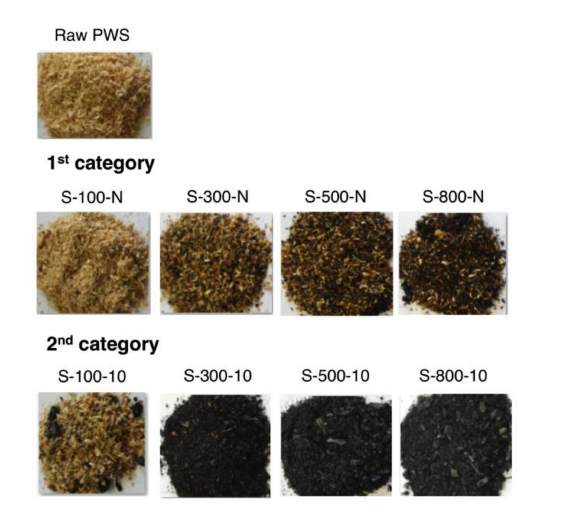
Figure 3. Aspects of the resulting chars obtained after microwave heating at different experimental